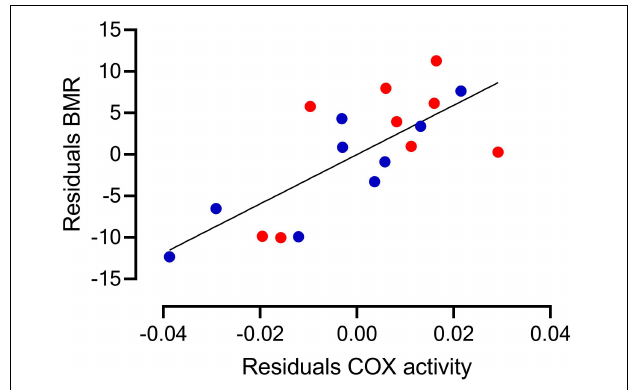
FIGURE 5 | Lipid peroxidation (A) , aqueous peroxides (B) , and total antioxidant capacity (C) measured in pectoral, heart, liver, plasma, and erythrocyte (RBC) in Z. capensis acclimated to control and water restriction conditions. Data are reports as mean ± SE. Asterisks denote significant differences between